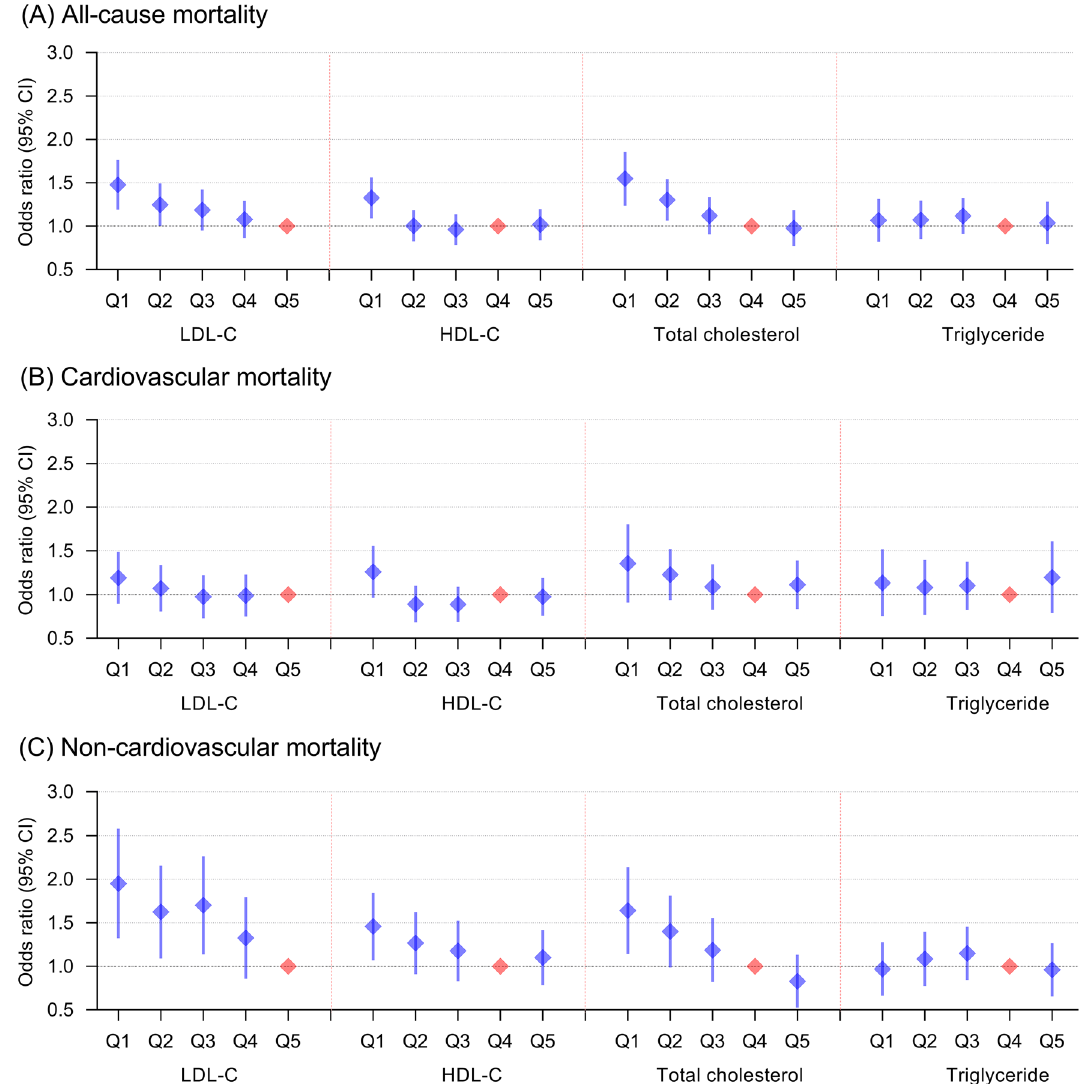
Figure 1. Multivariable adjusted odds ratios for all-cause and cause-specific mortality by quintiles of LDL-C, HDL-C, total cholesterol and triglyceride levels in the overall population. All-cause mortality ( A ), cardiovascular mortality ( B ) and noncardiovascular mortality ( C ) adjusted by age, sex, ethnicity, BMI, heart rate, mean blood pressure, disease severity score (APACHE score, Glasgow Coma Score), lab measurement (LDL-C, HDL-C, TC, TG, white blood cell, hemoglobin, platelet and albumin), primary disease of admission (circulatory disease, respiratory disease, digestive disease, neurological disease, genitourinary disease and endocrine disease), pre-admission comorbidities (ASCVD, diabetes, hypertension, heart failure, COPD and renal dysfunction), medication (lipid-lowering therapy, antiplatelet drug and anticoagulant), mechanical ventilation and